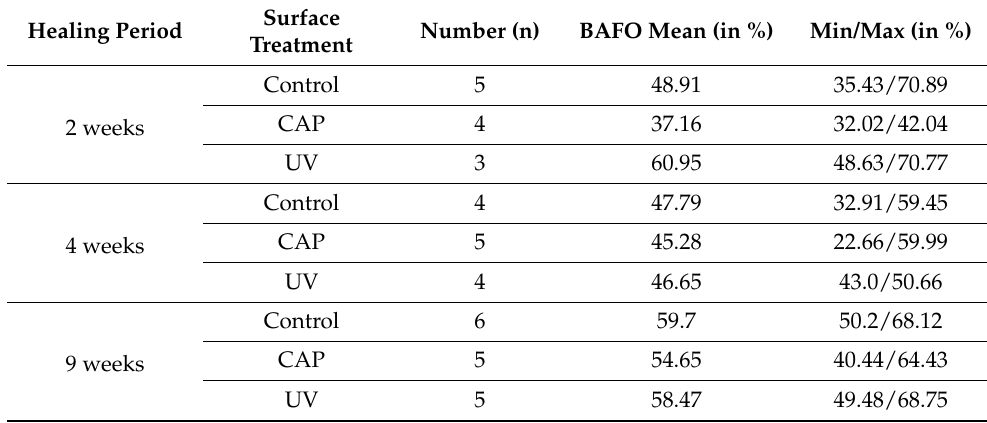
Table 2. BAFO values after 2, 4, and 9 weeks of healing.